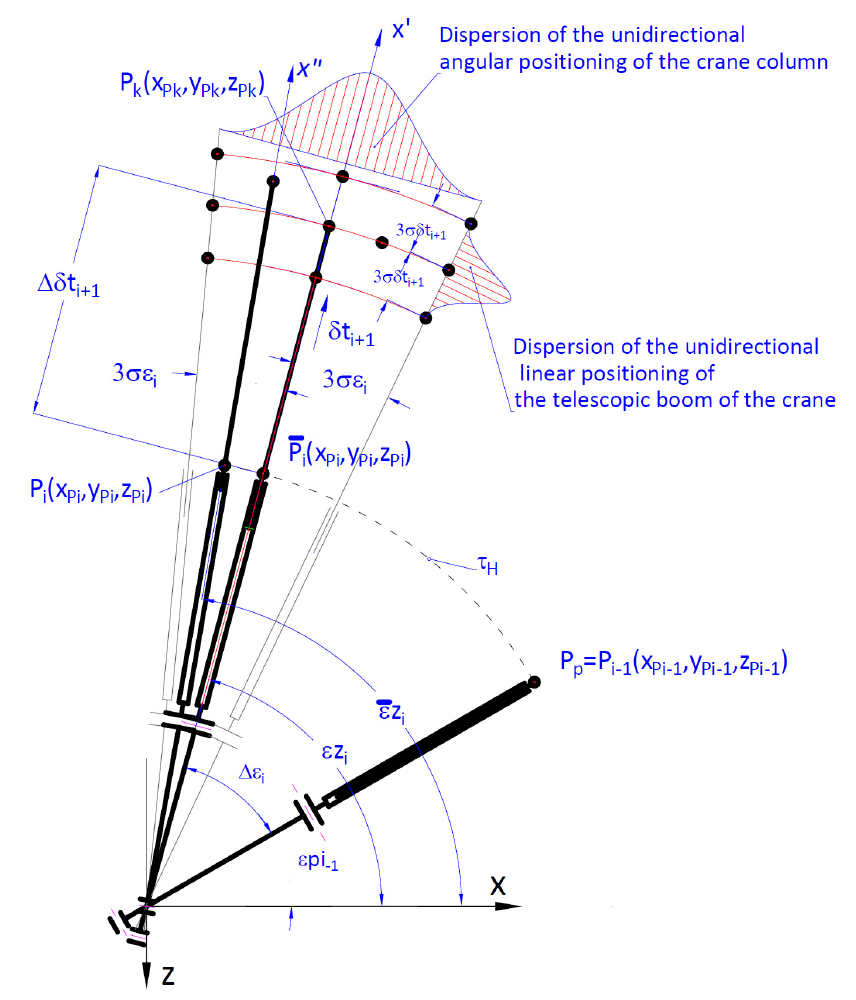
Figure 5. Diagram for calculating the accuracy of unidirectional positioning of the cargo handling crane: for transporting the cargo from the initial position P p to the set target position P k , where: x —axis of the system of coordinates in relation to which the angular orientation (on the example of the rotation of the crane column) is measured; x (cid:48) —axis of the set angular orientation relative for the measurement of linear displacement (on the example of a retractable telescopic boom), i —subsequent sequential movement of the crane, ε Z i —angle of the set position of x (cid:48) axis, ε Z i —mean value of the angular orientations, δ t Zi + 1 —set position according to linear orientation, ε Z i —mean value of the linear position, ± 3 σ ε i —dispersion of the angles in relation to the values ε Z i , ± 3 σ δ ti + 1 —dispersion of unidirectional linear displacement in relation to the value δ t Zi + 1